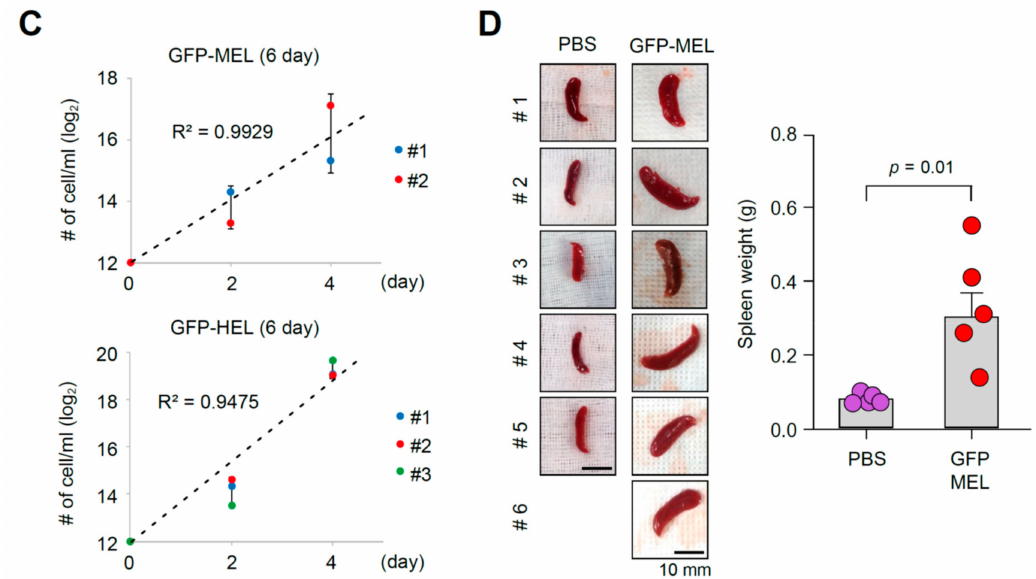
Figure 4. Analysis of erythroleukemia cell-transfused mice by subcutaneous injection as diagnostic models for validating tumorigenicity and metastatic potential. ( A ) Scheme of blood collection by eye bleeding for 17 days after GFP-expressing MEL or HEL cell transfusion using subcutaneous injection. Quantification of collected circulating GFP-positive MEL or HEL cells at every 2 days after transfusion for 17 days that showed stable cell numbers in blood stream at 144 h after transfusion. ( B ) Representative photographs showing the green fluorescence intensities and counts (panel A) for the GFP-expressing MEL or HEL cells in the blood sample by Arthur ™ (NanoEnTek Arthur TM, Seoul, Korea) histograms at every 2 days during 6 days. ( C ) Quantification curve of GFP-positive MEL at every 2 days during additional 4-day cultivation, the circulating blood sample collected at 6 days after transfusion. ( D ) Photographs of spleens dissected out from the mock (top; n = 5) and GFP-expressing MEL (middle; n = 6) cell-transfused mice (right; n = 6) at 17 d after systemic injection. Splenomegaly was only observed in GFP-expressing MEL cell-transfused mice. Significance of each combination was tested by Student’s t